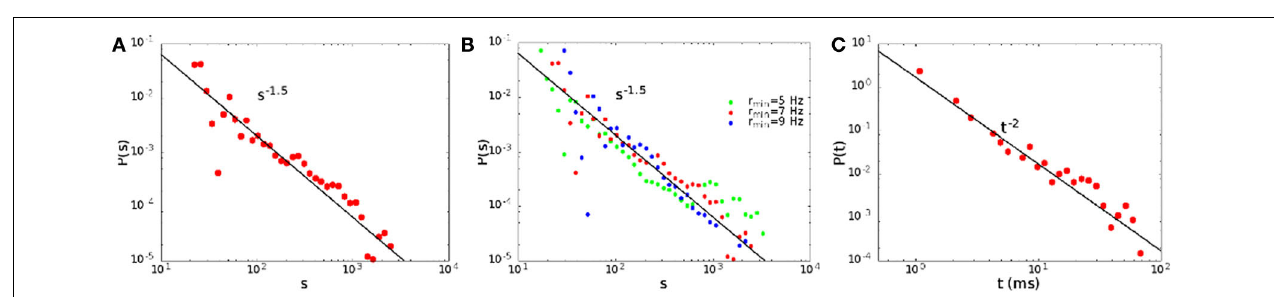
FIGURE 5 | The size (A) and duration (C) distribution of the avalanches for H 0 = 0 . 221, α = 0 . 06, point B in Figure 2B. In (B) we show the dependence of the size distribution on the threshold rate R min .